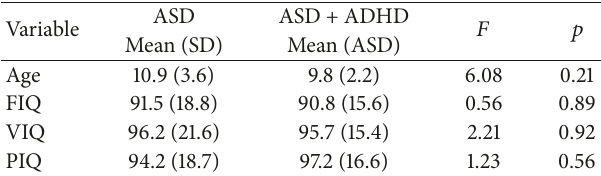
Table 1: Background